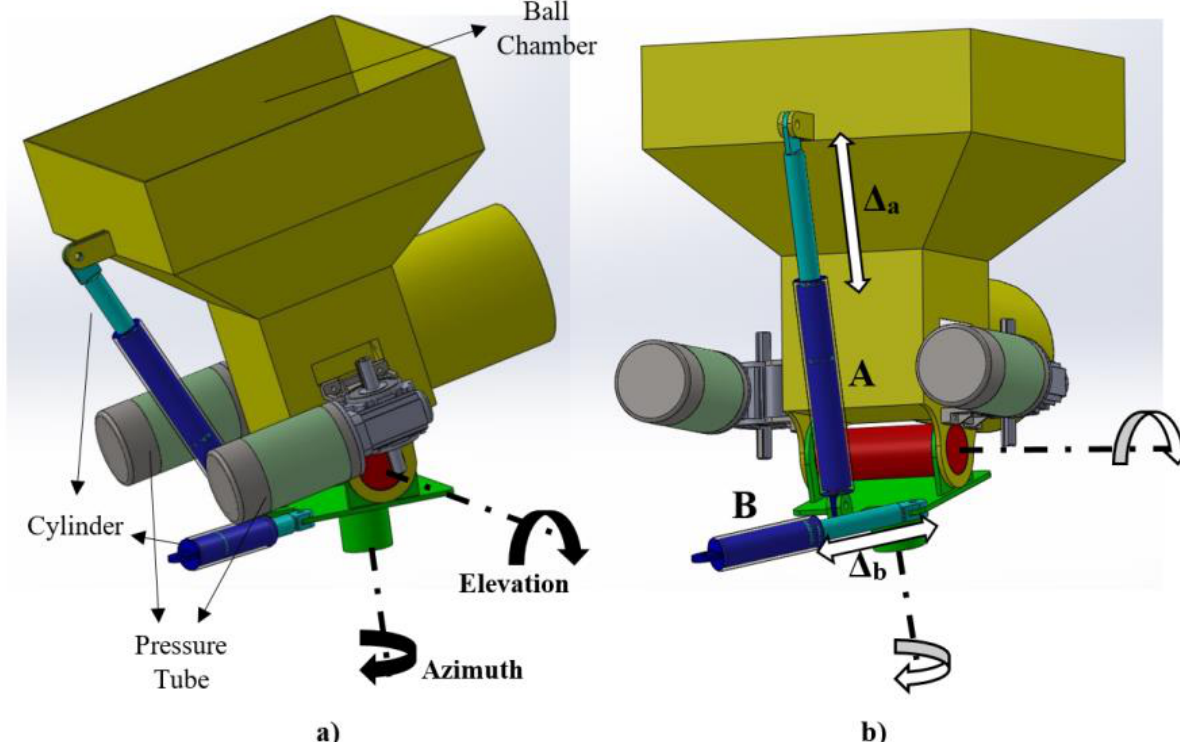
Figure 6. ( a ) Components used in the shooting turret ( b ) Shooting turret mechanism.